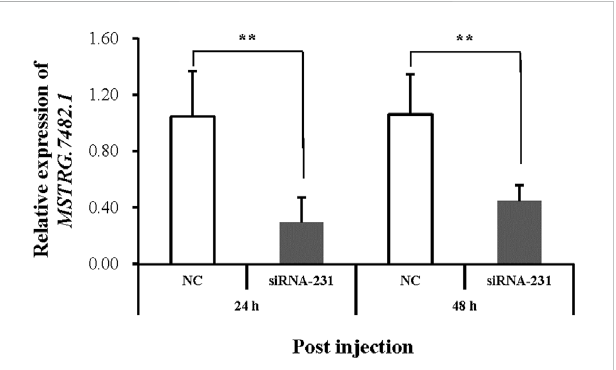
FIGURE 8 Relative expression of MSTRG.7482.1 after injection with siRNA. Asterisks on the error bars show signi fi cant differences ( p <